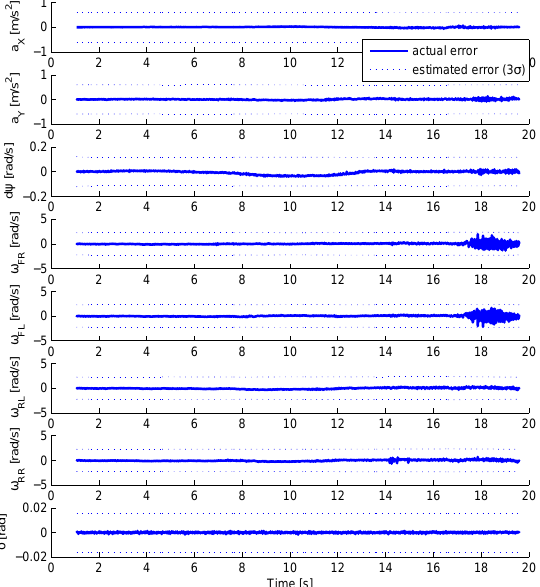
Figure 4. Estimation error consistency check during an emergency